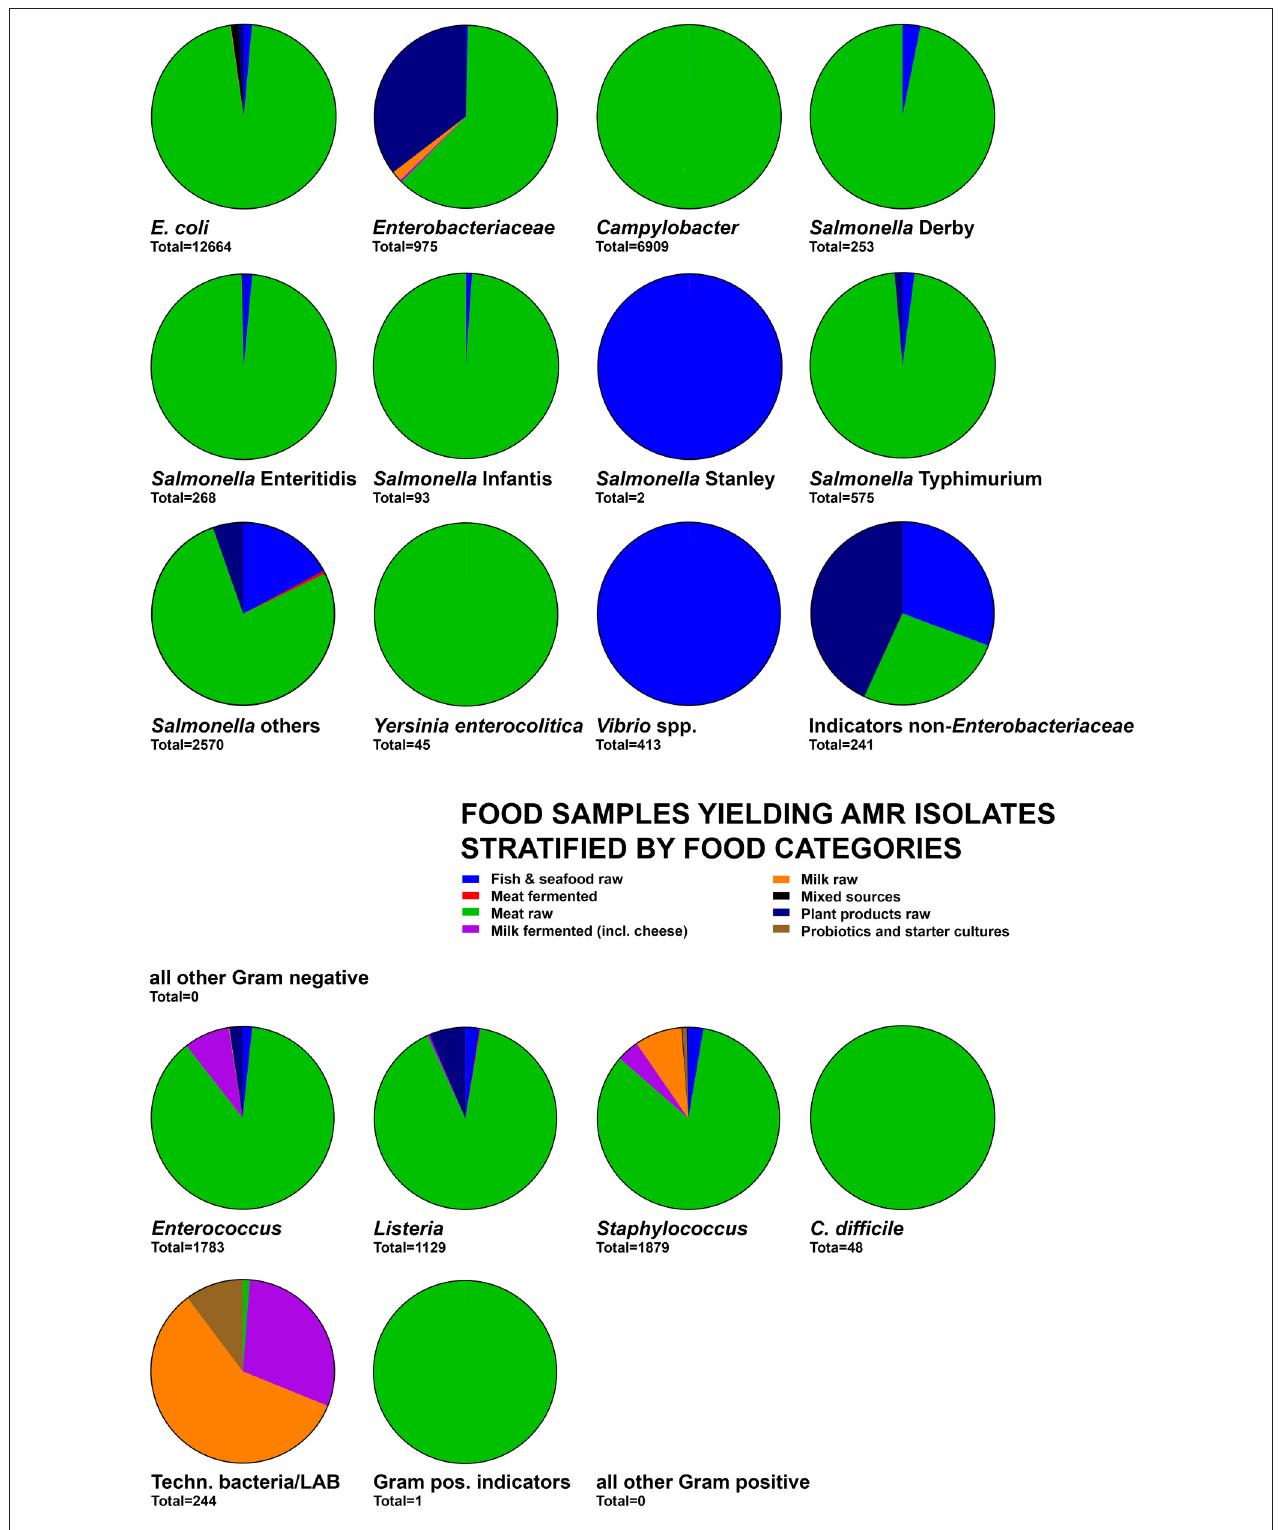
FIGURE 2 | Distribution of the number of food samples detected positive for AMR isolates and stratified by food categories. The total below each pie chart indicates the total of samples used to calculate the graph. For other Gram-negative, other Gram-positive, and Gram-positive indicator groups, no or only limited quantitative sample association was possible and thus no diagram was obtained despite the presence of AMR phenotypes in these groups.